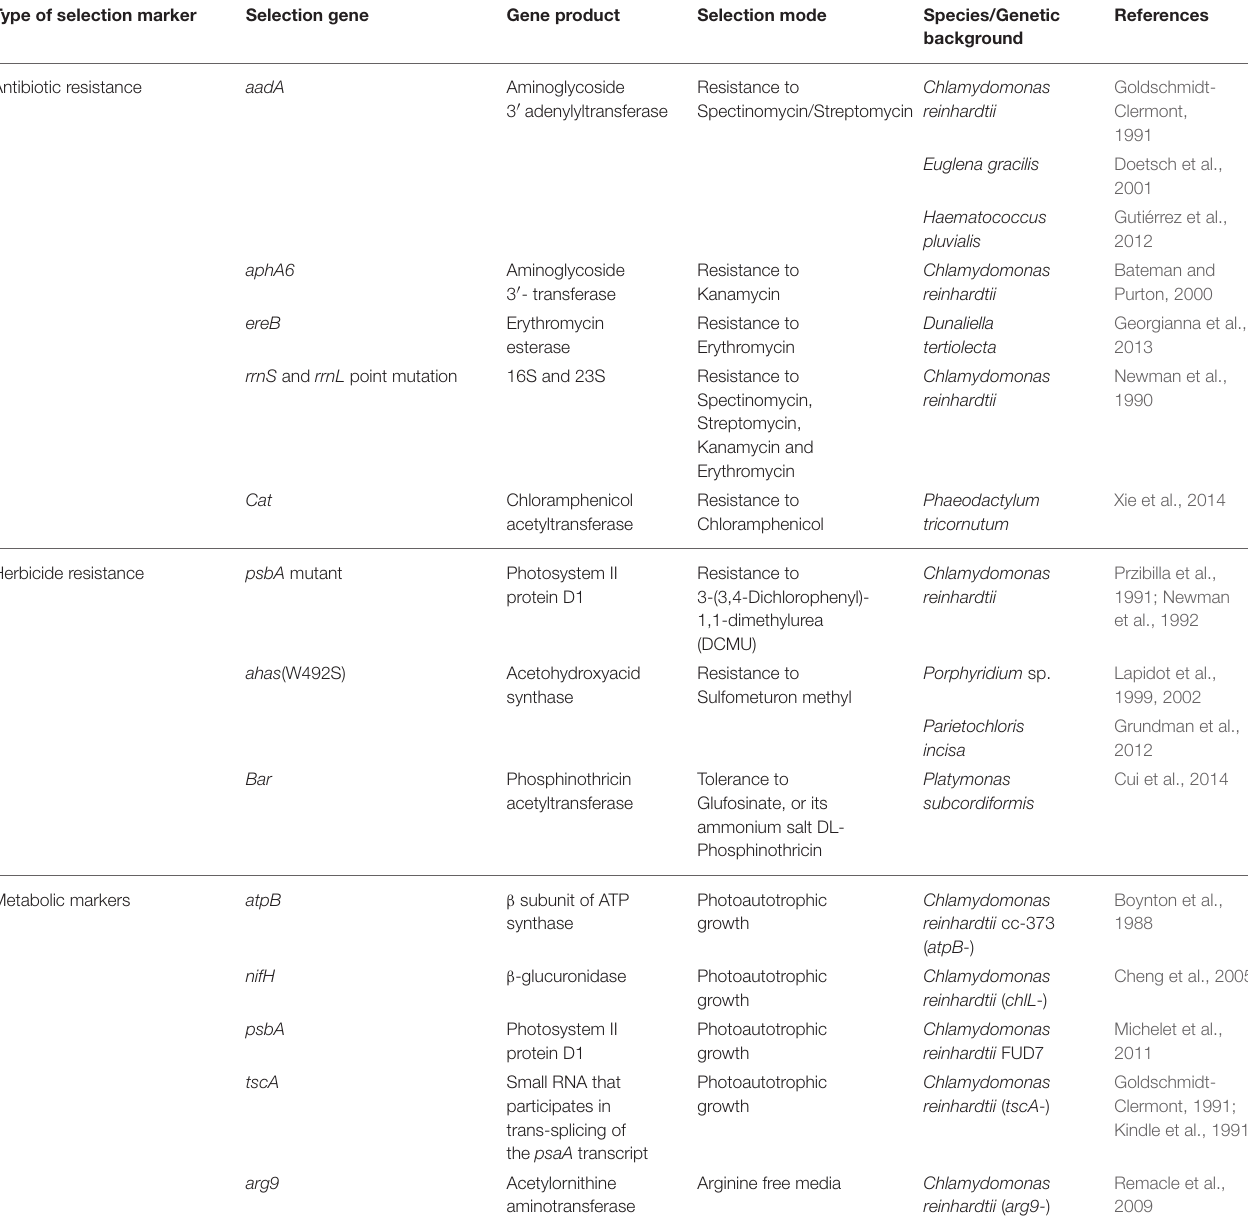
TABLE 1 | List of selection markers and selection modes for chloroplast